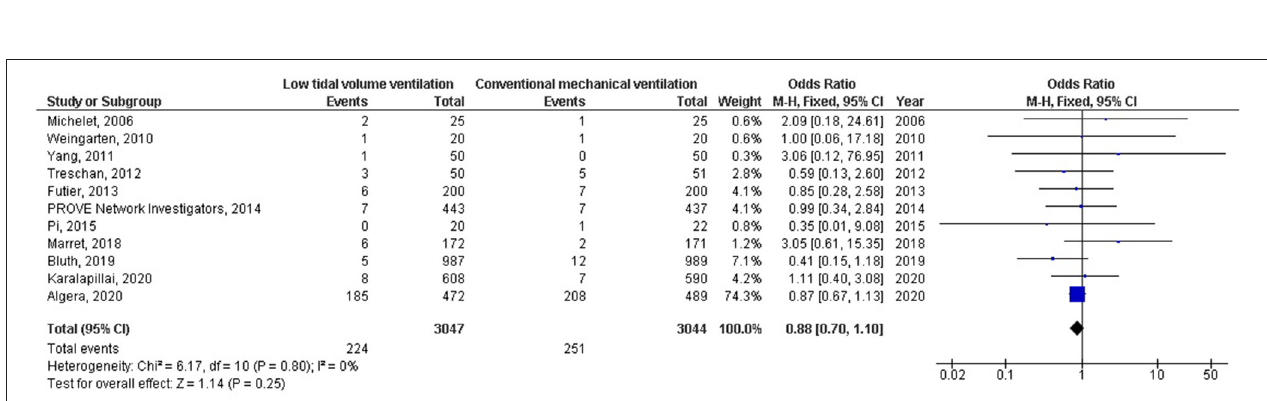
FIGURE 4 | Forest plot of the low tidal volumes strategy vs. conventional mechanical ventilation in subjects undergoing surgery on short-term mortality.